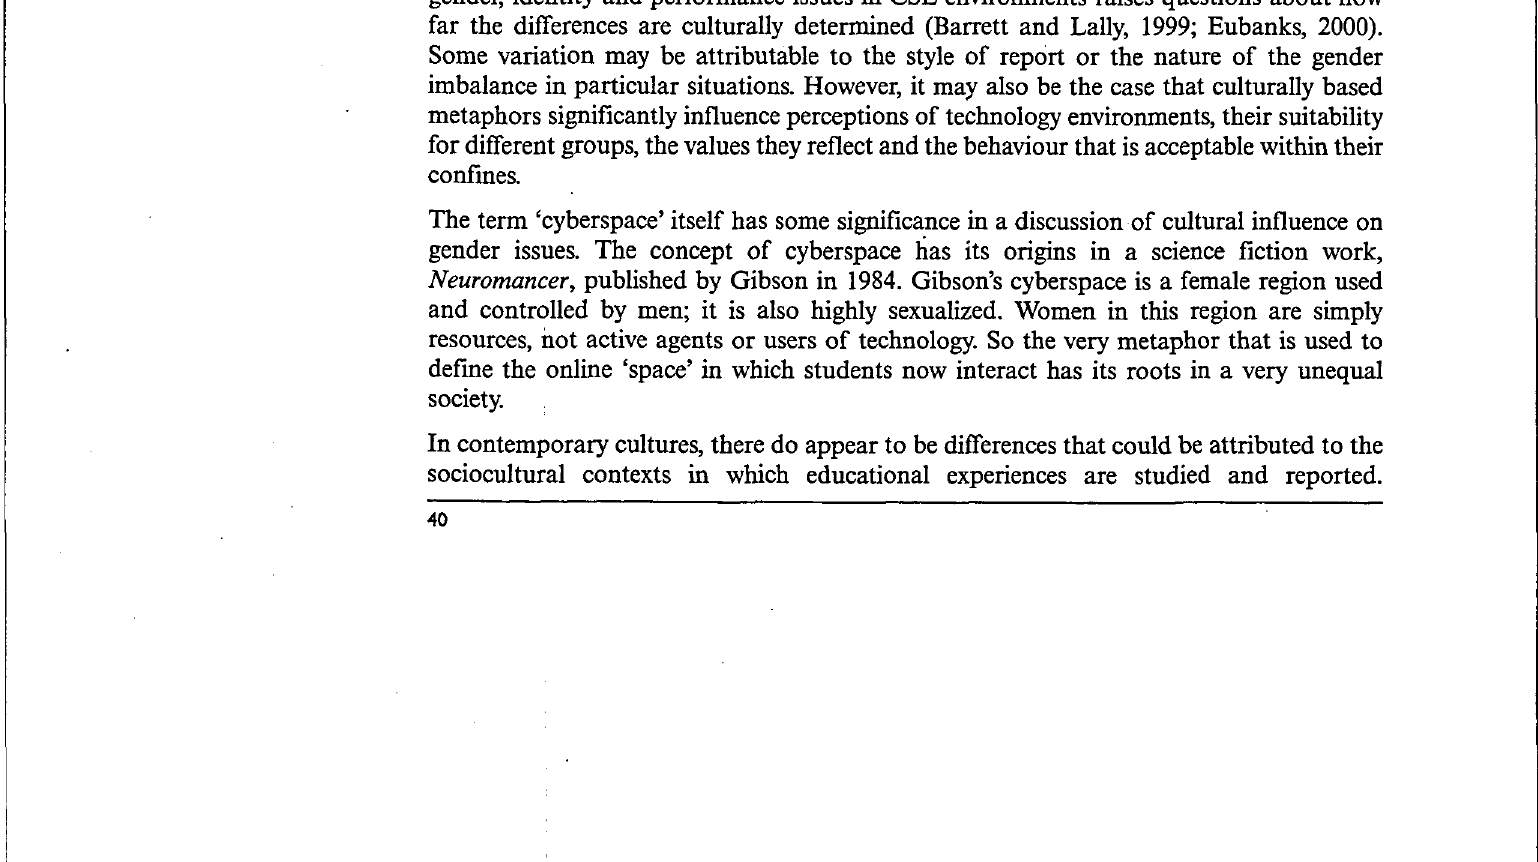
Table I: System data of male and female student participation in CSL